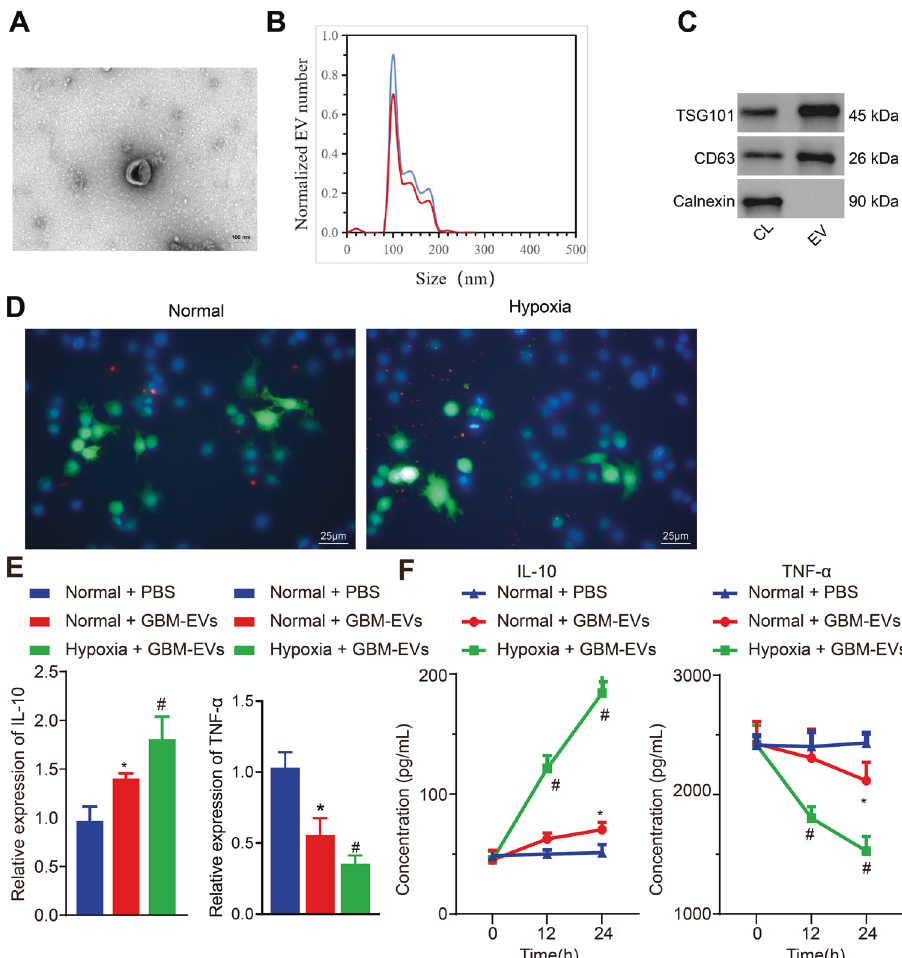
Fig. 1 GBM-EVs promote M2 polarization. A TEM results of GBM-EVs (scale bar = 100 nm). B NTA results of the size distribution of EVs. C Expression of marker proteins TSG101, CD63 and Calnexin in 5 μ g GBM-EVs and 20 μ g cell lysates determined using Western blot analysis. D Immuno fl uorescence images of EV uptake by macrophages under normoxia/hypoxia (double label; red represents EVs; green indicates macrophage) (scale bar = 25 μ m). E RT-qPCR results of IL-10 and TNF- α mRNA expression in macrophages. F ELISA results of the secretion levels of IL-10 and TNF- α in the supernatant of macrophages. * p < 0.05 compared with the normal cells treated with PBS. # p < 0.05 compared with normal cells treated with GBM-EVs. The experiment was repeated 3 times